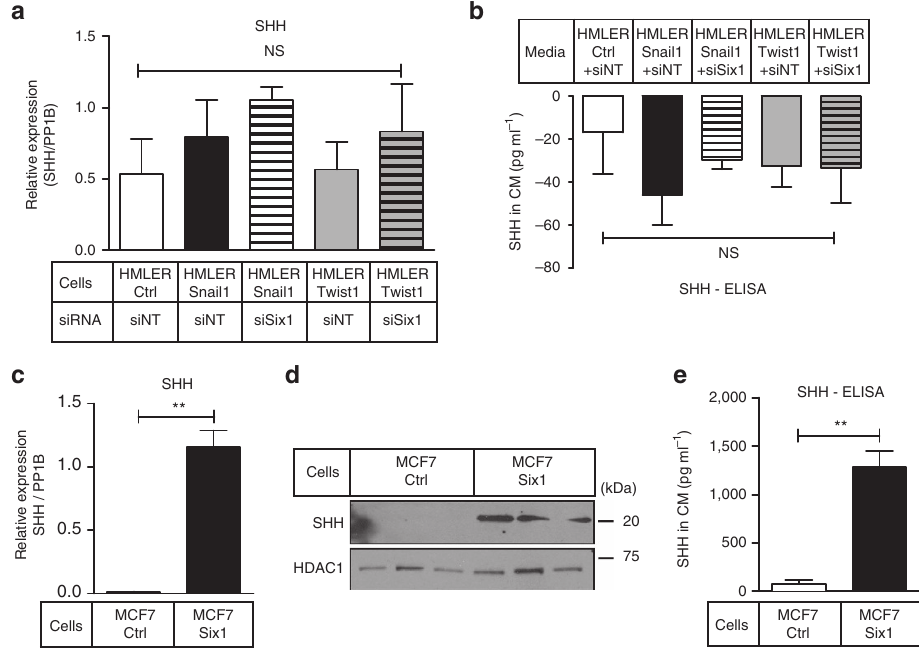
Figure 3 | SHH is upregulated downstream of Six1 in specific contexts. ( a ) Quantitative real-time PCR (qRT–PCR) analysis (on mRNA isolated from cells) and ( b ) ELISA analysis on CM from HMLER-Ctrl, Snail1 and Twist1 cells transfected with 150nM of siSix1 or siNT. ( c ) qRT–PCR analysis on mRNA isolated from three different MCF7-Ctrl versus MCF7-Six1 clones (clones of same cell type combined) normalized to PP1B, ( d ) western blot analysis on WCLs using antibodies against SHH and HDAC1 as a loading control, ( e ) ELISA on CM from three different clones of MCF7-Ctrl and MCF7-Six1 cells (clones combined in e ). s.e.m. shown, compiled experiments n Z 3. One-way ANOVA with Tukey’s post test for a , b and two-tailed unpaired t -test for c , e . NS, not significant; ** P -value o